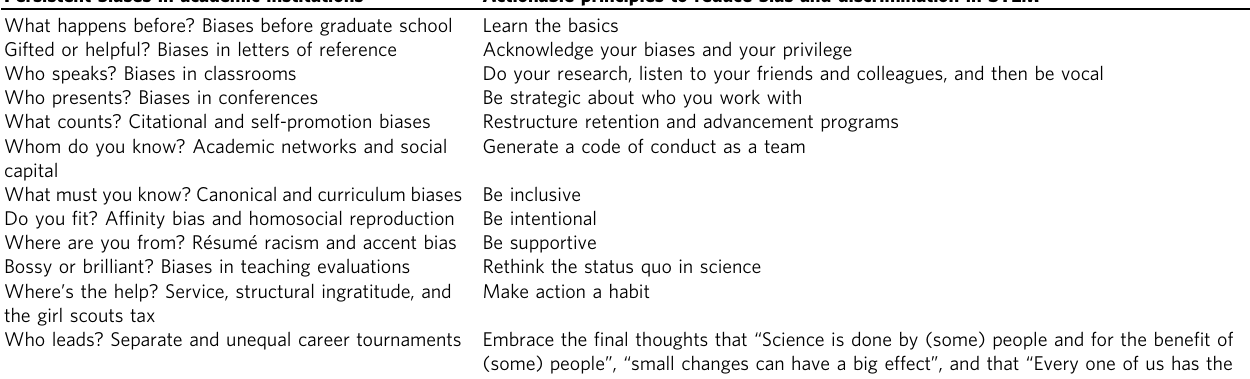
Table 1 A side-by-side list of twelve persistent biases in academic institutions 15 and principles to reduce bias and discrimination in science, technology, engineering, and mathematics (STEM) 17